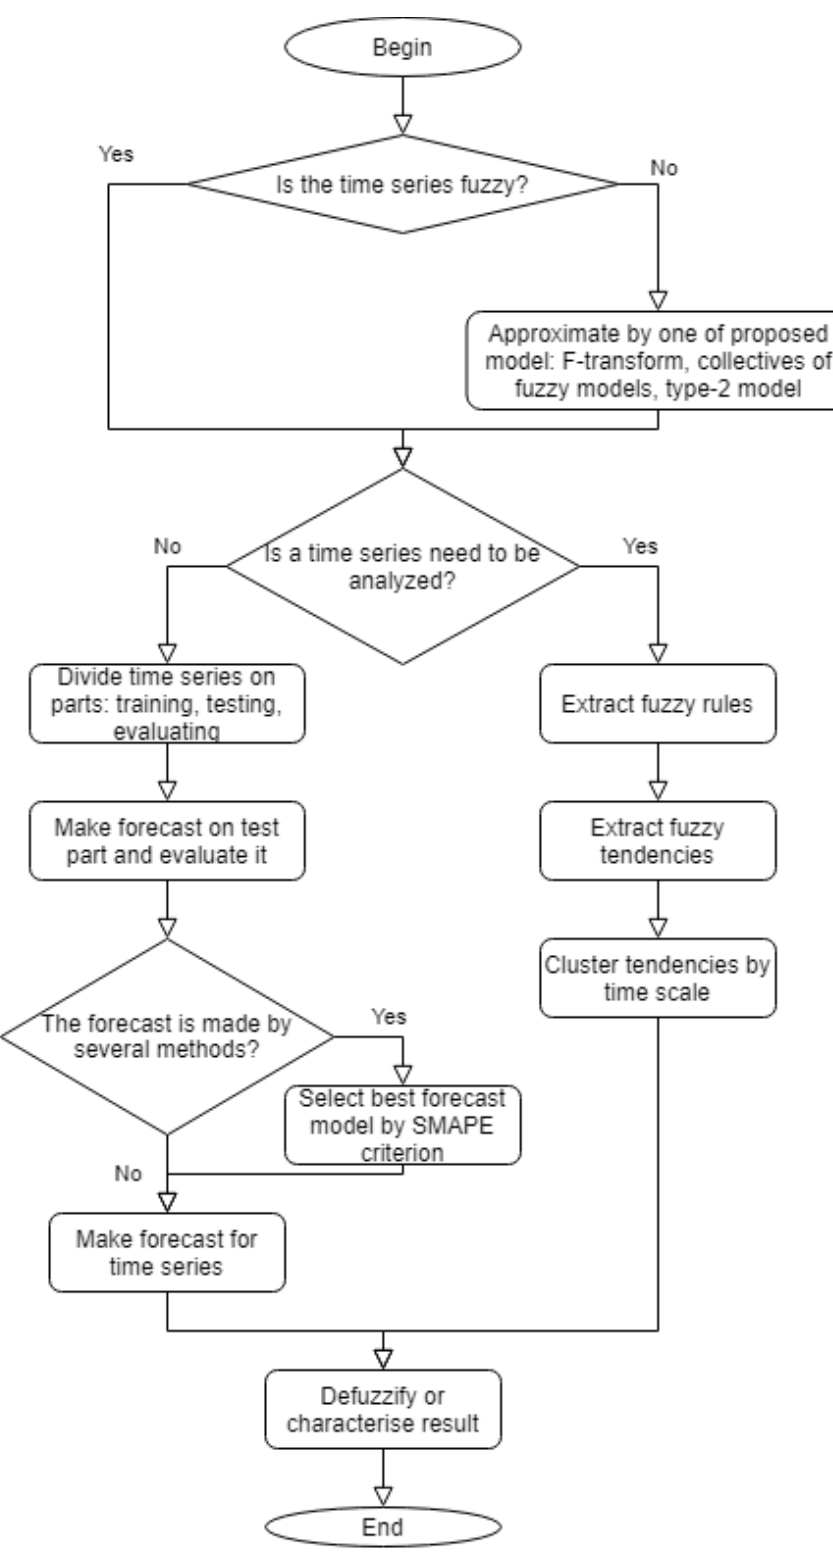
Figure 3. The general steps of time series